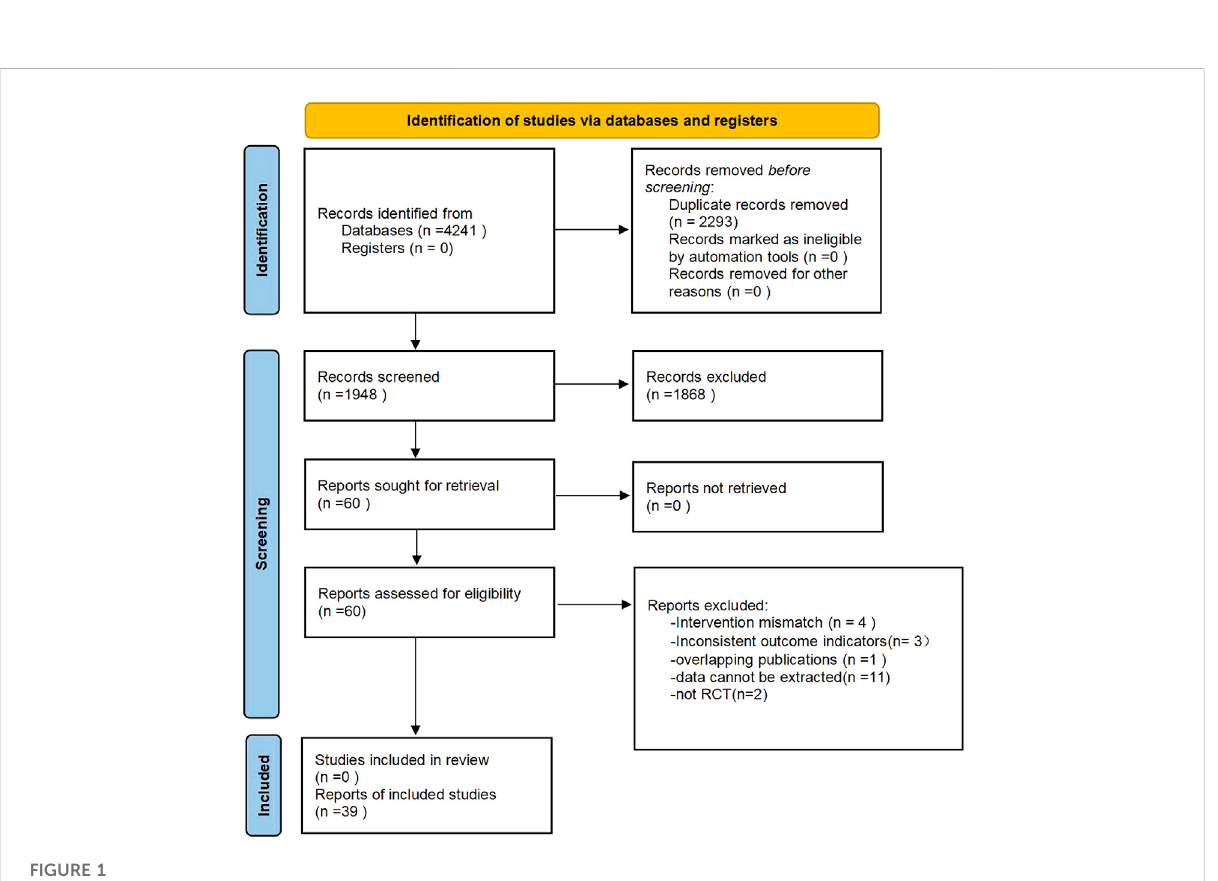
FIGURE 1 PRISMA diagram of